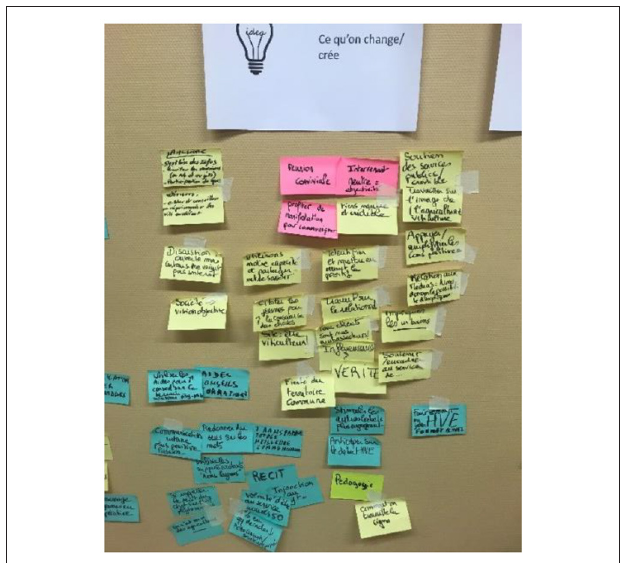
FIGURE 4 | Example of the Keep-Drop-Create analysis in the